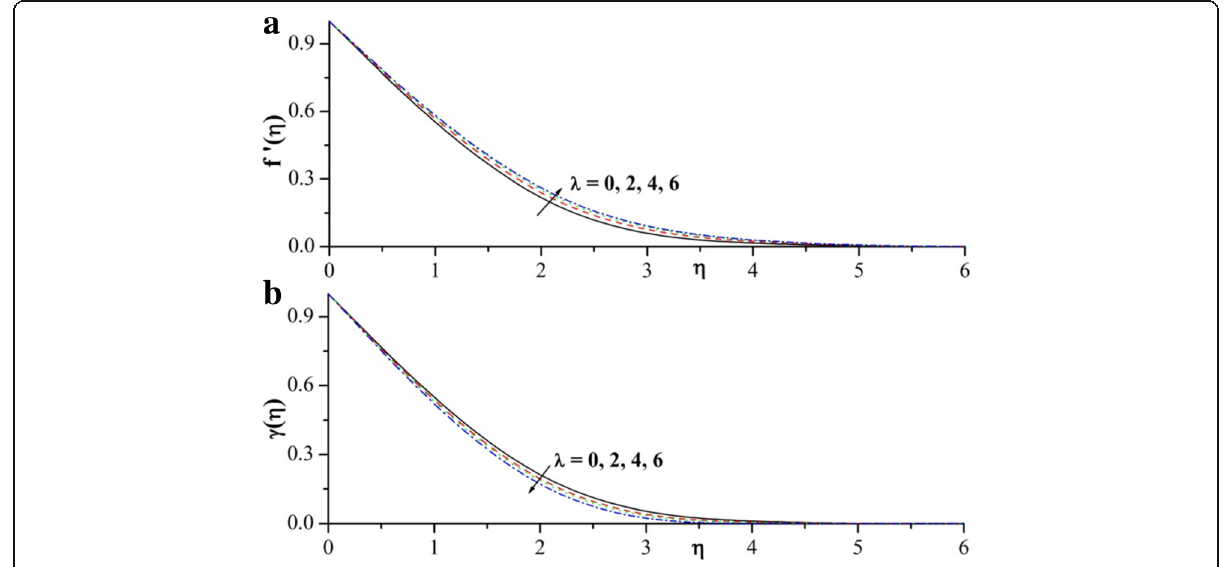
Fig. 4 a Velocity and b solute concentration profiles for variable values of λ